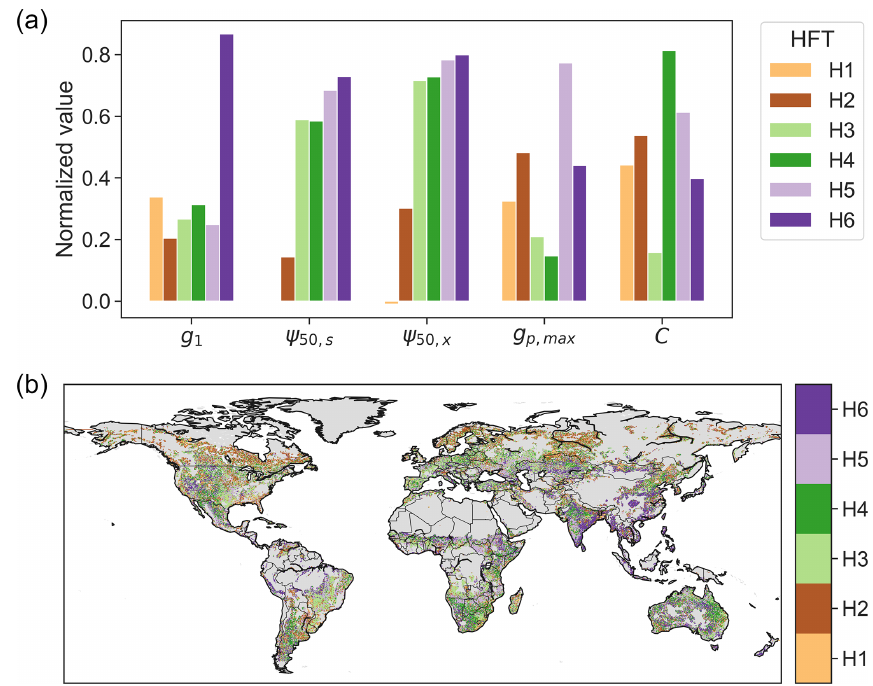
Figure 7. (a) Plant hydraulic traits of the centers of six hydraulic functional types and (b) their spatial pattern. Each trait of cluster centers is normalized using (V − V 5 )/(V 95 − V 5 ) , where V is the trait magnitude, and V 5 and V 95 are the 5th and 95th percentiles of the corresponding trait across the study area.